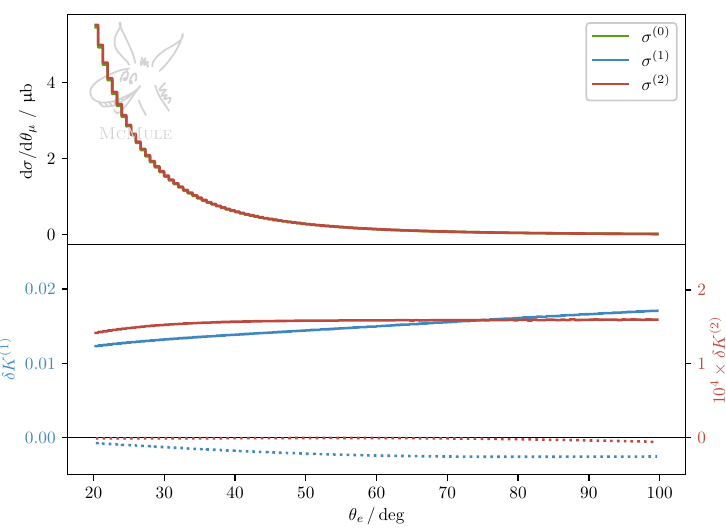
Figure 11: Differential cross section d σ/ d θ for MUSE with incoming muons of mo- µ mentum 210 MeV, at LO (green) and NNLO (red) with K factors. Solid (dotted) K factors are with (without) the inclusion of VP